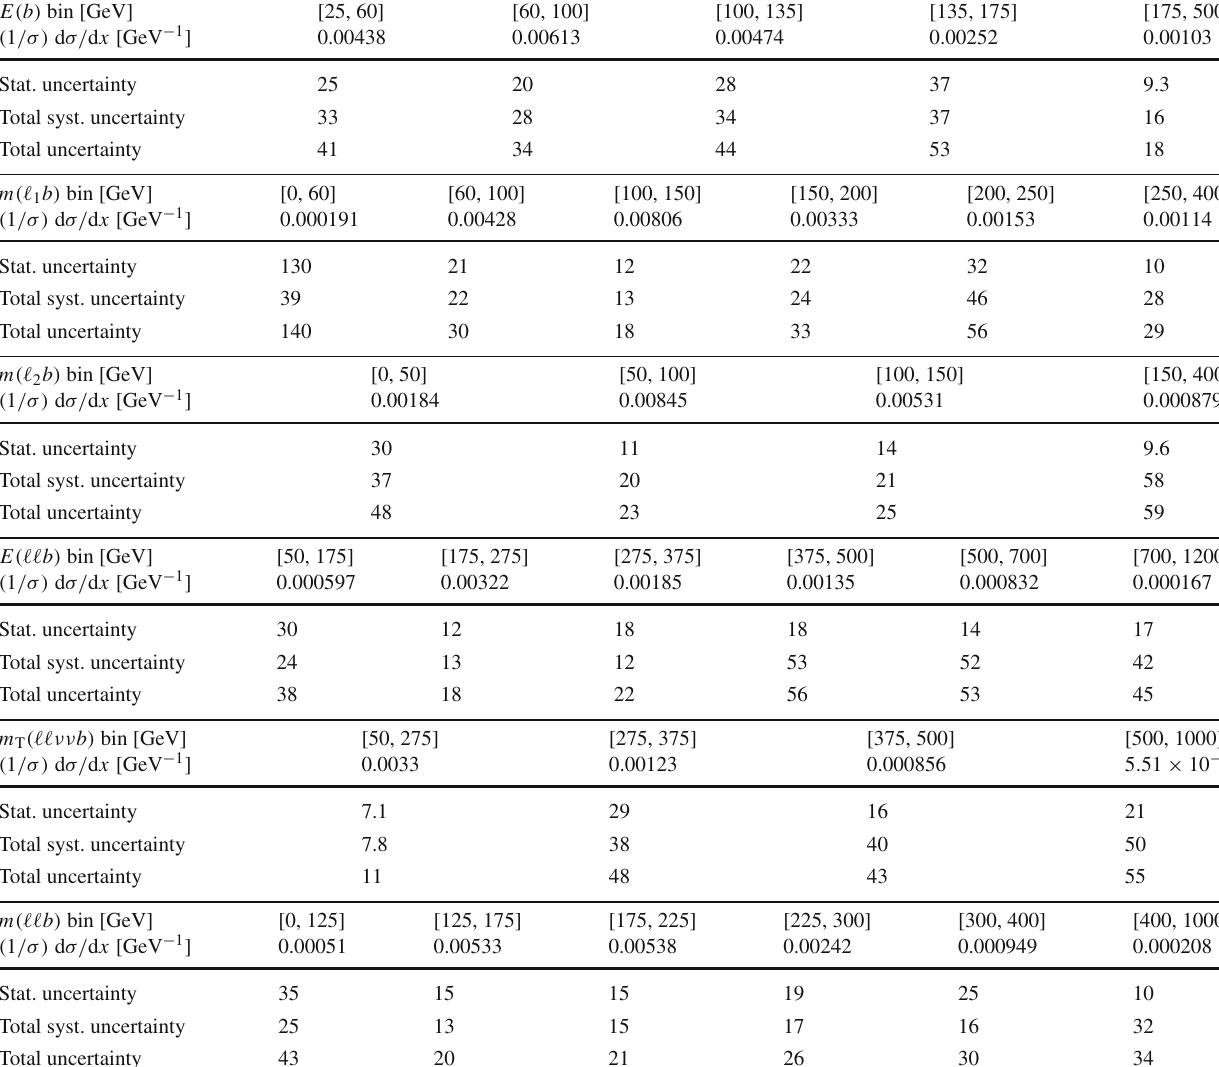
Table 4 Summary of the measured normalised differential cross-sections, with uncertainties shown as percentages. The uncertainties are divided into statistical and systematic